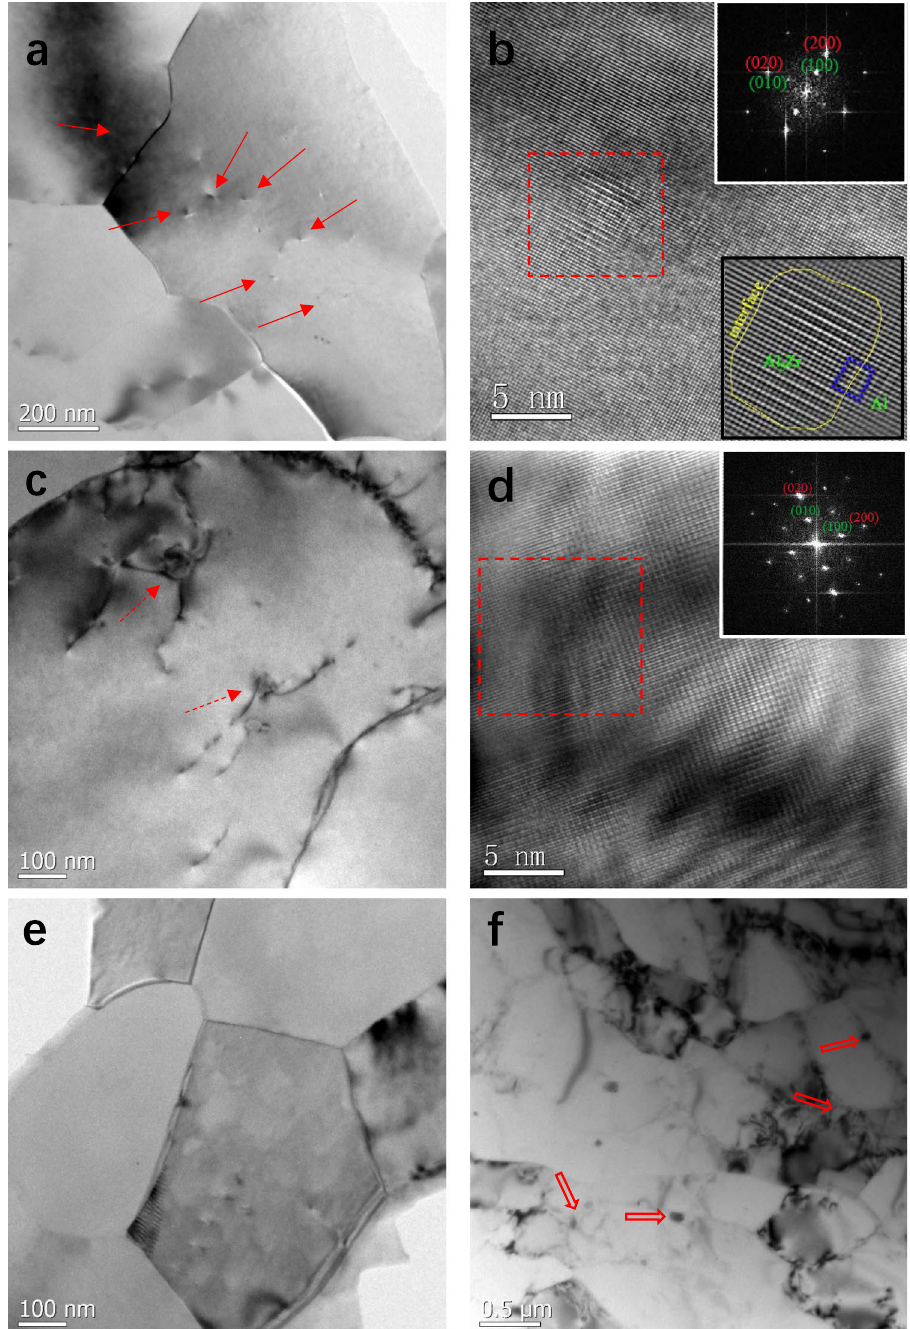
Figure 3. Representative TEM and HRTEM images of the Al-Zr conductors with different processing routes. ( a ) And ( b ) are TEM and HRTEM images to show the fine coherent Al 3 Zr precipitates (marked by solid arrows) within the grain interior in the III-type-265 Al-Zr conductor, respectively. ( c ) And ( d ) are TEM and HRTEM images to show the coarse and incoherent Al 3 Zr precipitates (marked by dash arrows) in the III-type-400 Al-Zr conductor, respectively. The FFT images respectively inserted in top-right corner of ( b ) And ( d ) are used to identify the Al 3 Zr precipitate with L1 2 structure, and the IFFT image inserted in the bottom-right corner of ( c ) to demonstrate the coherent interface between the Al 3 Zr precipitate and Al matrix, where a typical closed Burgers circuit at the interface shows no misfit dislocations. Note the FFT and IFFT images are corresponding to the region marked by a red dash box. ( e ) is a TEM image of II-type-265 Al-Zr conductor where no precipitates are observed. ( f ) Is a TEM image to show intergranular Al 3 Zr precipitates (marked by open arrows) in the II- type-400 Al-Zr